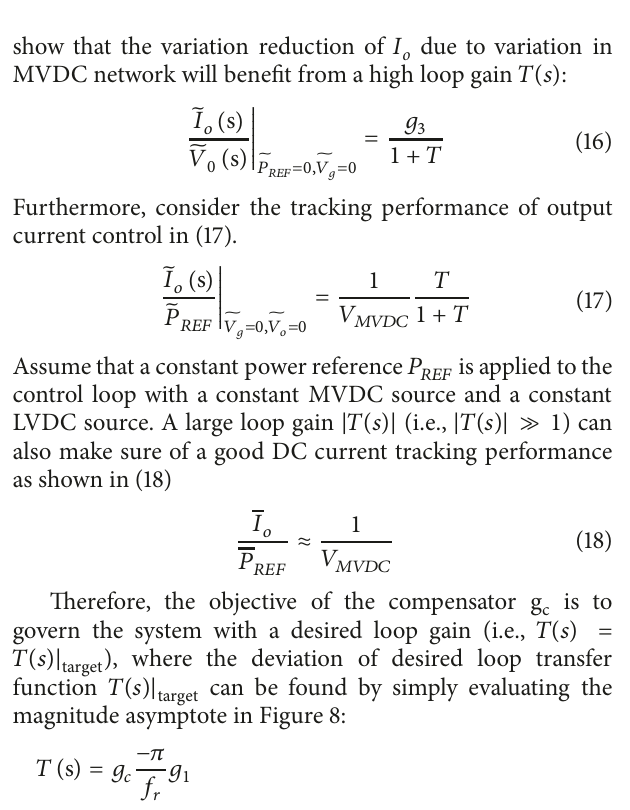
||T| (target curve of loop gain) target